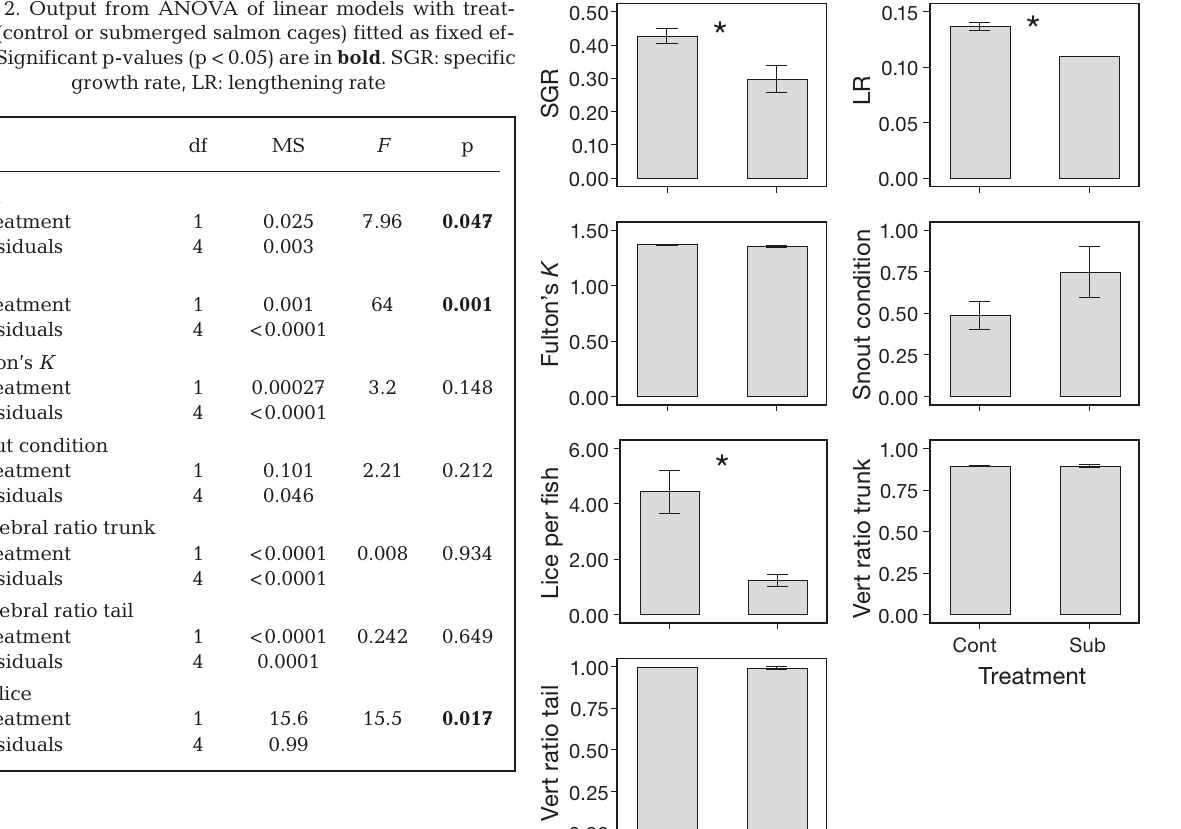
Table 2. Output from ANOVA of linear models with treat- ment (control or submerged salmon cages) fitted as fixed